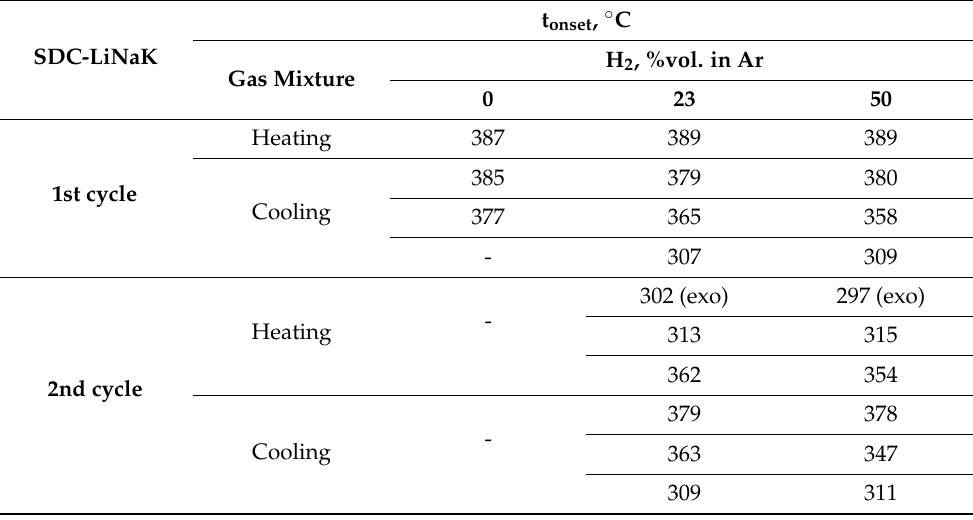
Figure 4. Impact of H 2 content diluted in dry N 2 (from 0 to 100 %vol.) on the electrical stability of the SDC—LiNaK composite. Arrhenius diagrams correspond to each part of a cycle and are shown separately: ( a ) 1st heating; ( b ) 1st cooling; ( c ) 2nd heating; and ( d ) 2nd cooling. Table 2. Transition temperature (t onset ) dependence on H 2 percentage in Ar for SDC—LiNaK elec- trolyte powder detected by DSC studies during one or two heating/cooling scanning cycles. All peaks are endothermic during heating if the opposite is not indicated; all peaks are exothermic during each cooling